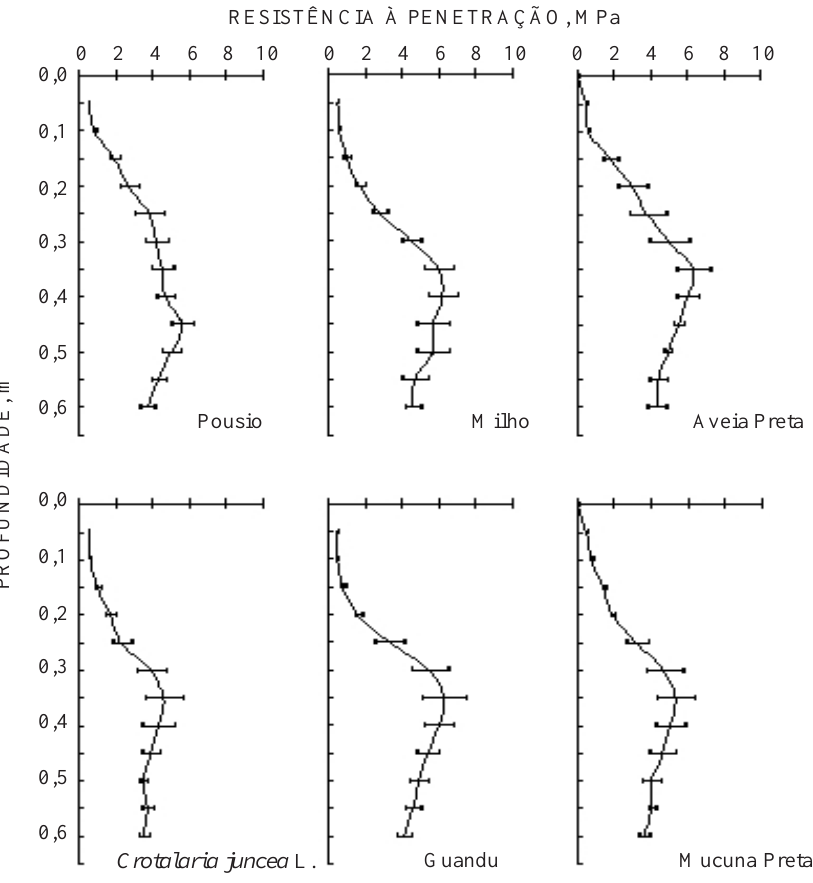
Crotalaria juncea Figura 2. Valores médios de resistência à penetração ± erro-padrão da média, em MPa, com penetrômetro de impacto modelo IAA/PLANALSUCAR, em diferentes profundidades, em Latossolo Vermelho eutroférrico típico cultivado com feijoeiro e após rotação com culturas graníferas e adubos verdes.